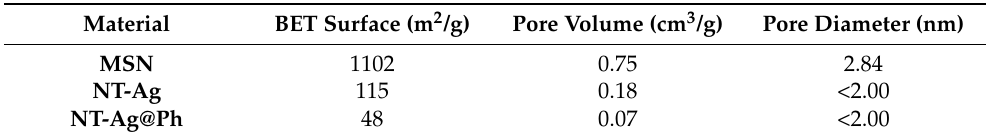
Table 1. Textural parameters of selected MSN materials obtained from nitrogen adsorption– desorption analysis.